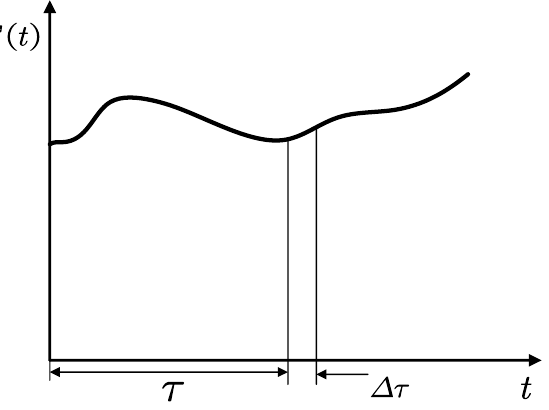
Figure 1. F ( t ) can be decomposed into discrete impulse excitations.